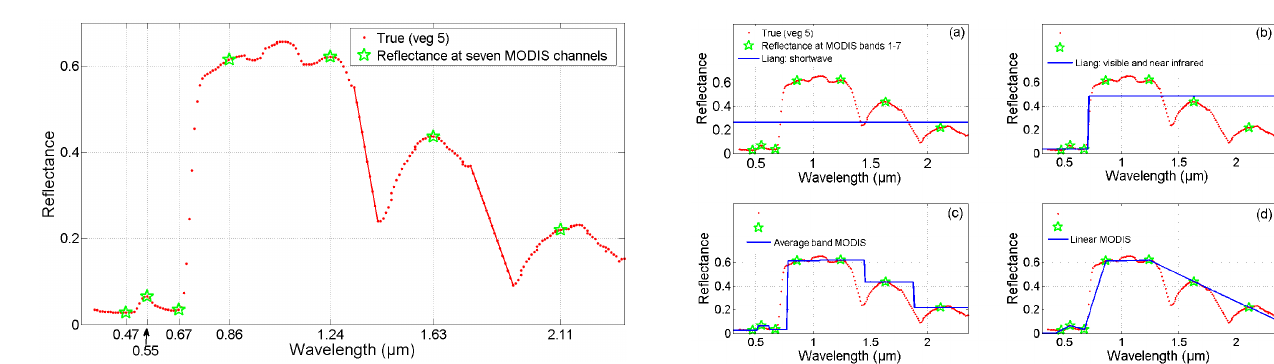
Fig. 3. Traditional approaches to estimate the continuous reflectance spectra based on MODIS bands 1–7: Liang short wave, Liang vis- ible and near infrared, average band MODIS, and linear MODIS. In each subplot, the x-axis represents the wavelength from 0.3 to 2.35µm; the dotted red curve is the spectral reflectance for miconia guianensis as shown in Fig. 2; the green stars represent the cor- responding reflectance at MODIS bands 1–7; the solid blue lines represent each traditional